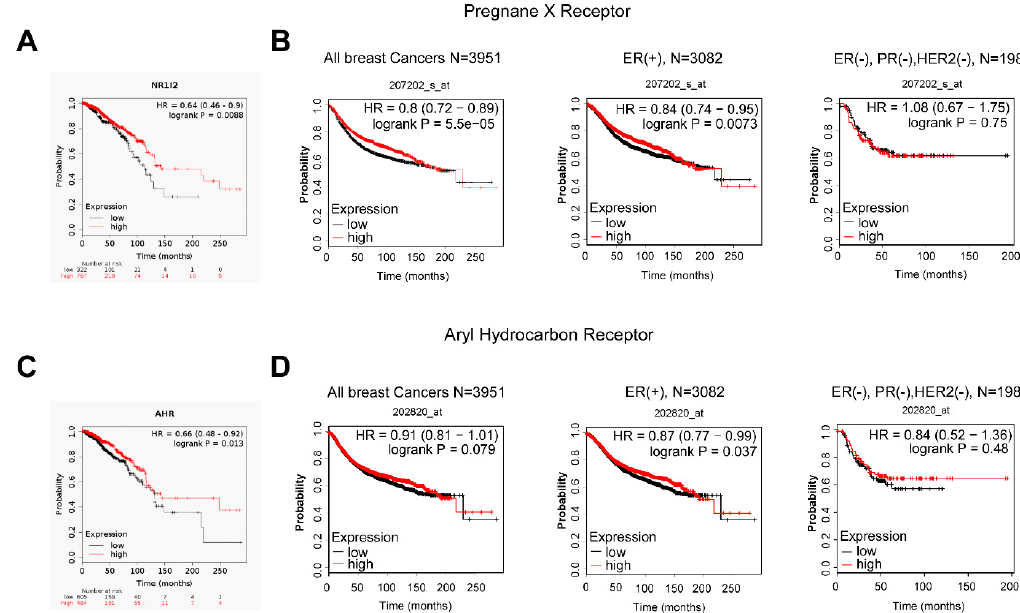
Figure 7. Higher expression of pregnane X receptor and aryl hydrocarbon receptor prolongs survival in breast cancer. The e ff ect of expression of ( A ) AHR or ( B ) PXR on survival in breast cancer was analyzed by kmplot.com, which is a freely accessible database. On panel ( A ), the e ff ect of PXR expression on survival is depicted with the data acquired from RNAseq experiments. On panel ( B ), the e ff ect of PXR expression on survival is depicted with the data acquired from microarray experiments, and patients were stratified as a function of receptor expression. On panel ( C ), the e ff ect of AHR expression on survival is depicted with the data acquired from RNAseq experiments. On panel ( D ), the e ff ect of AHR expression on survival is depicted with the data acquired from microarray experiments, and patients were stratified as a function of receptor expression. Total survival rates were assessed, and all samples are represented. Abbreviations: NR1I2—pregnane X receptor, Aryl hydrocarbon receptor (AHR), Pregnane X receptor (PXR) The database was assessed the 19th February 2020.